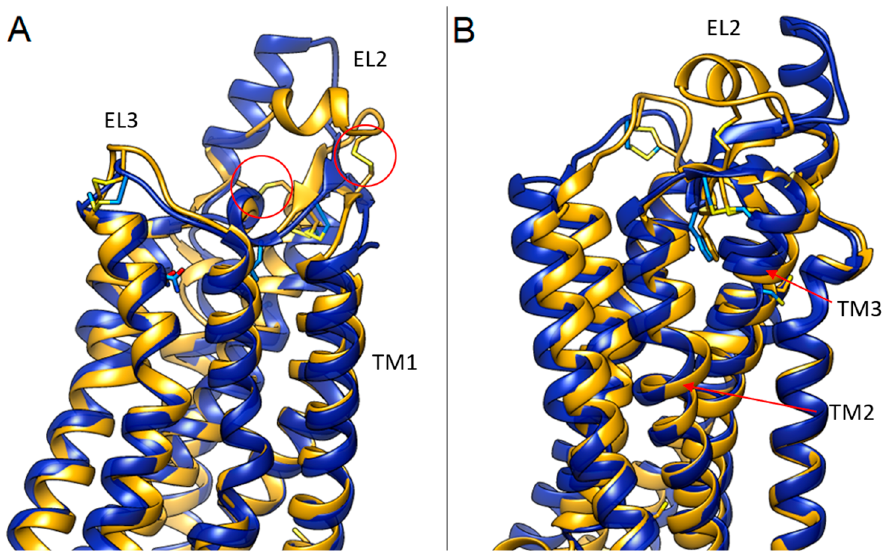
Figure 1. Structural superposition of hA 1 (dark blue) and hA 2a (gold) ARs crystal structures in their active state (PDB code: 6D9H and 2YDO, respectively). Panel A and B representations differ only for camera orientation. Additional A 2A disulfide bridges are highlighted in red.